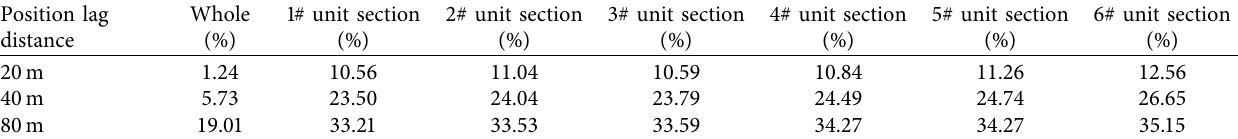
Table 5: Percentage increase of displacement with the change of support lag spacing (compared to 10m). Position lag distance